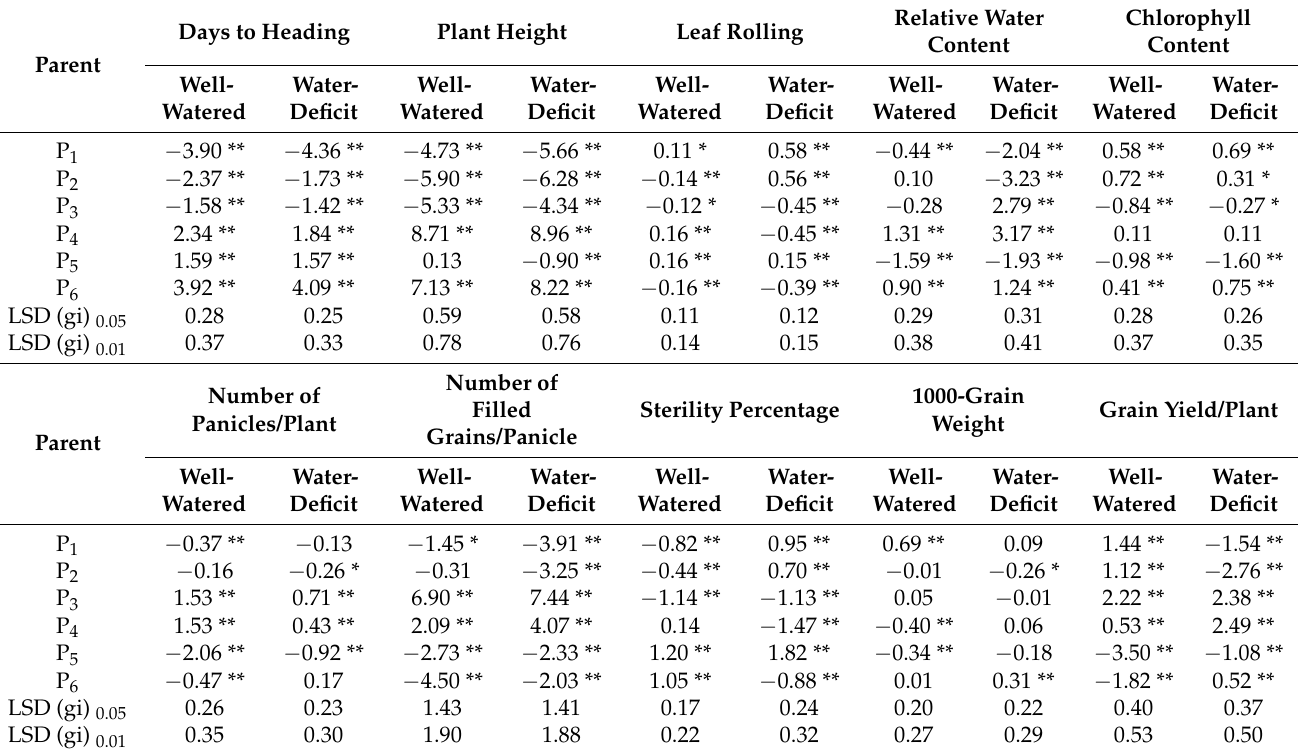
Table 3. General combining ability estimates (GCA) of the six parents for all the studied traits under well-watered and water-deficit